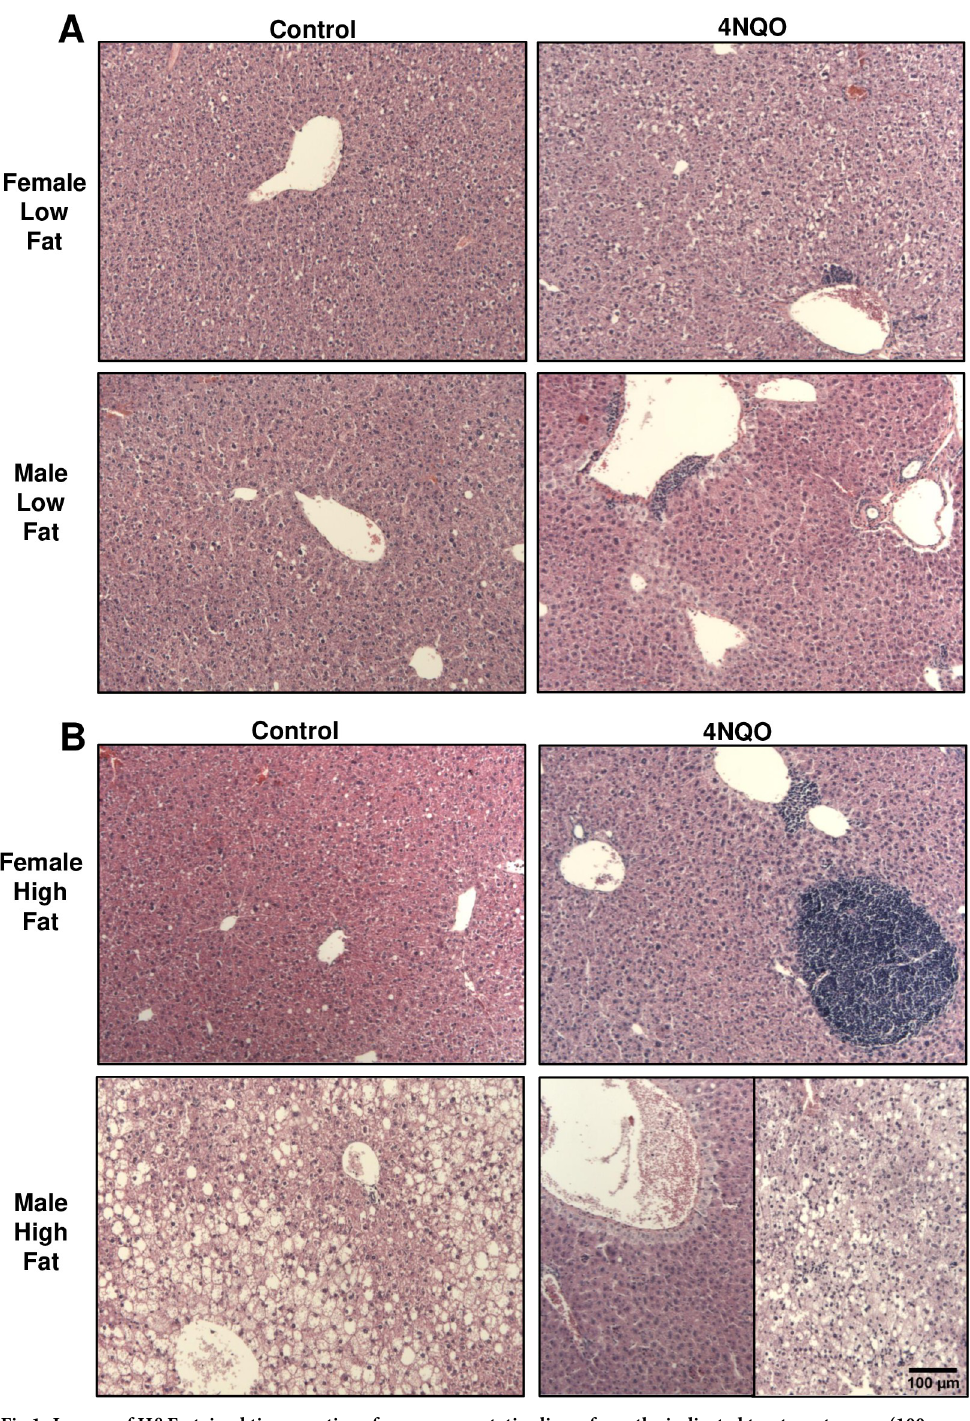
Fig 1. Images of H&E-stained tissue sections from representative livers from the indicated treatment group (100x magnification). (A) Control and 4NQO-treated male and female mice on a LF diet. (B) Control and 4NQO-treated male and female mice on a HF